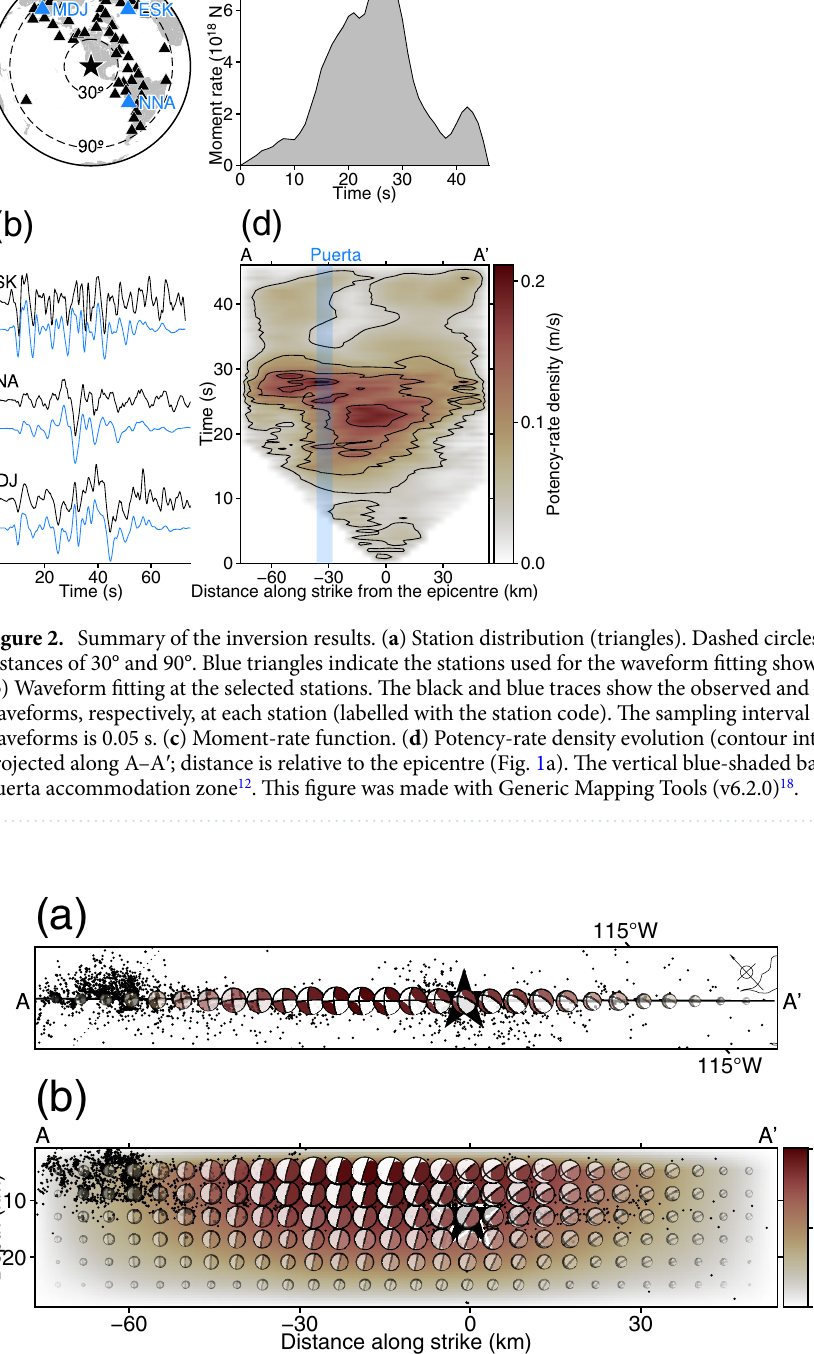
Figure 3. Potency density tensor distribution. ( a ) Potency density tensors at the top of the assumed model plane with a dip of 90°, projected onto an oblique map of the area along A–A ′ . The dotted line shows the U.S.– Mexico border. ( b ) Cross section of the potency density tensor distribution on the assumed model plane. The beachballs in ( b ) are shown in cross-sectional view from the southwest side. The star shows the hypocentre used for the inversion. Black dots show relocated seismicity 3 days after the mainshock 13 . This figure was made with Generic Mapping Tools (v6.2.0) 18